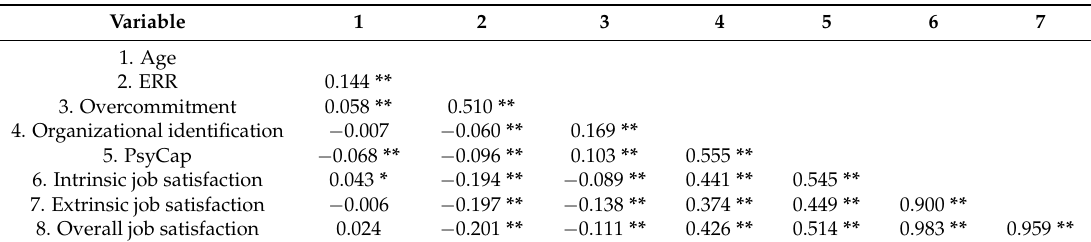
Table 3. Correlations among job stress, organizational identification, PsyCap and job satisfaction.